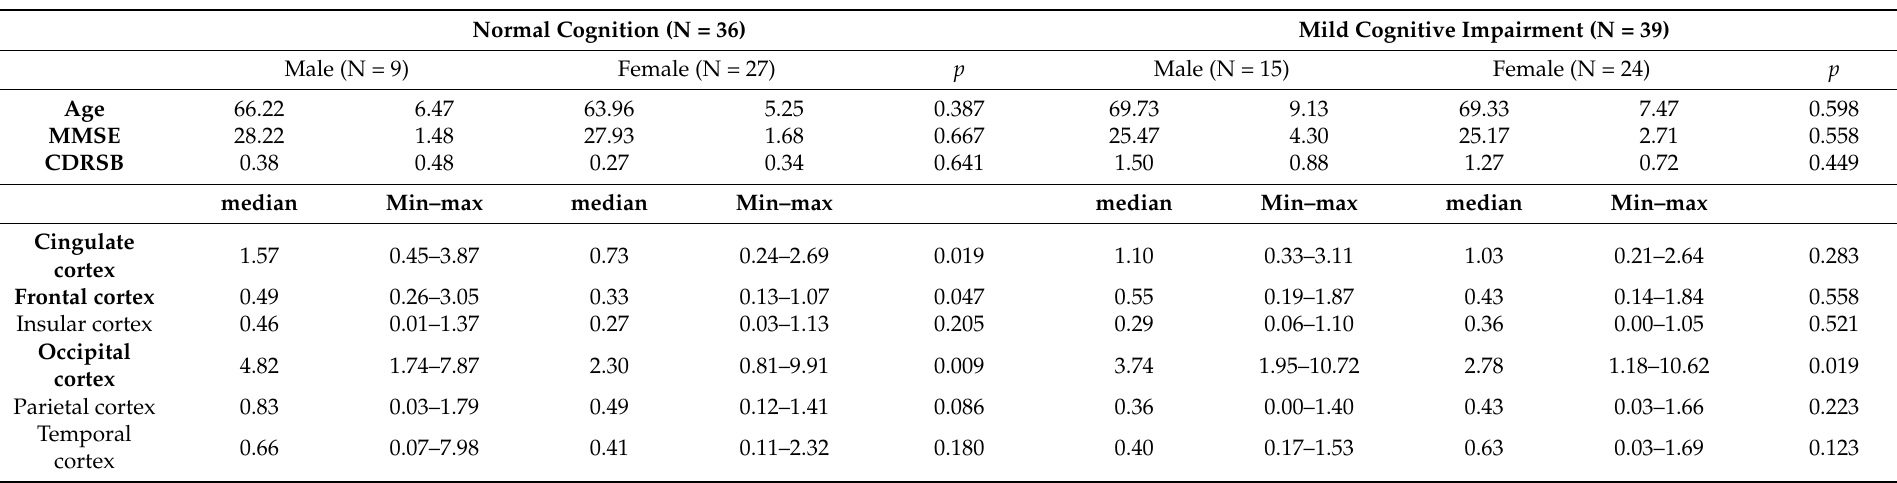
Table 4. Comparison of cerebral regional K trans according to the sex when classified by cognitive